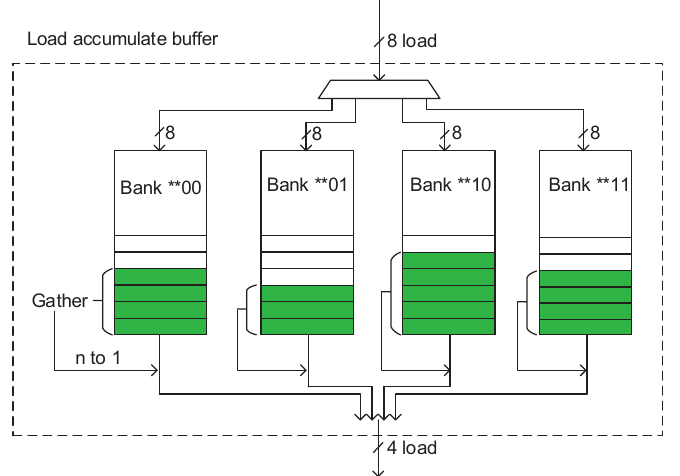
Figure 27. The schematic diagram of the load accumulate buffer. “*” in this image represents any binary